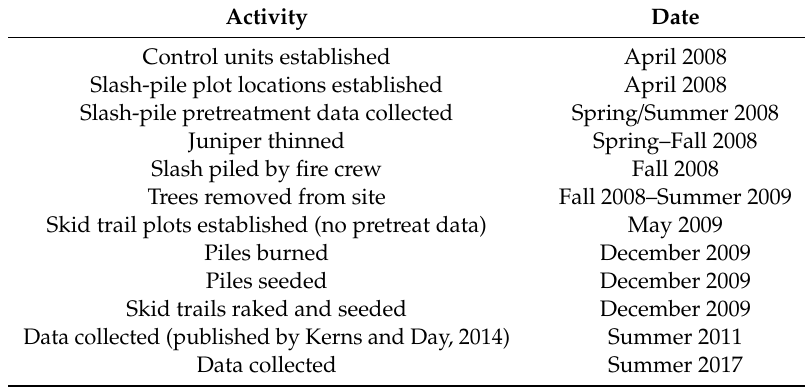
Table 1. Timeline of activities for this study. Data reported in this paper were collected in 2017, eight growing seasons after seeding in the winter of 2009.